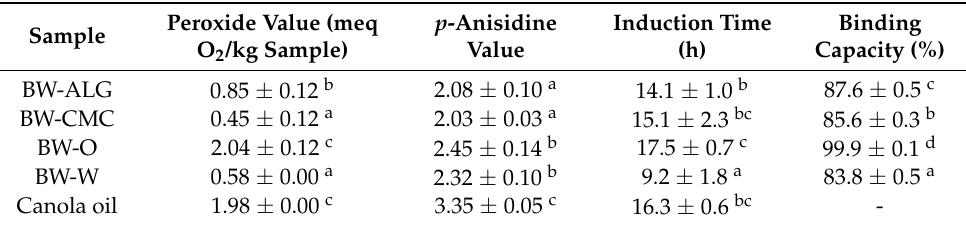
Table 2. Physical and chemical properties of bigels (BW-ALG and BW-CMC, oleogel (BW-O), the mixture of BW-O with distilled water (BW-W), and canola oil). Peroxide Value (meq Sample O 2 /kg Sample)